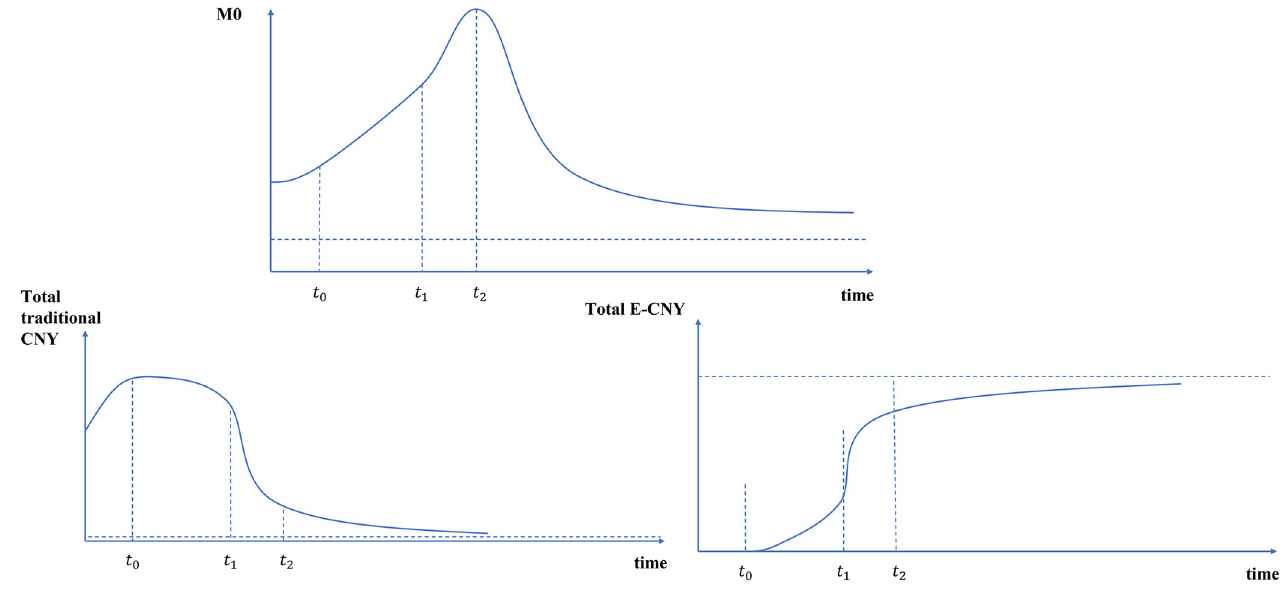
Fig 3. Path changes of M0 after e-CNY issuance.